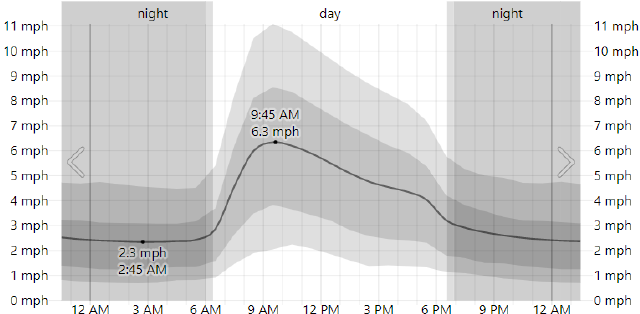
Figure 13. Wind speed on 2 February in Ambato. The average of mean hourly wind speeds (dark